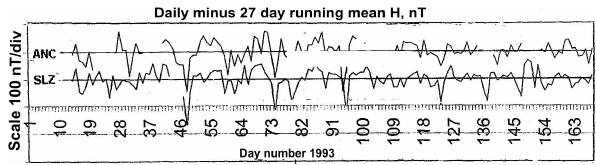
Fig. 3a. Day-to-day variations of the daily ranges of H at ANC and SLZ after removing the 27-day running mean plotted for the period January to June 1993.